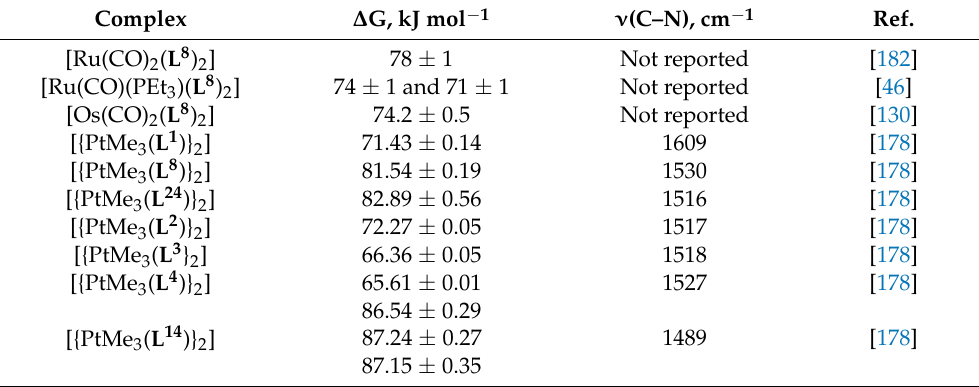
Table 10. Contemporary data for the barrier to rotation about the C–N bonds of platinum-group metal